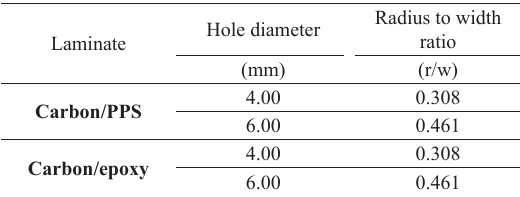
Table 2. Test conditions for open hole